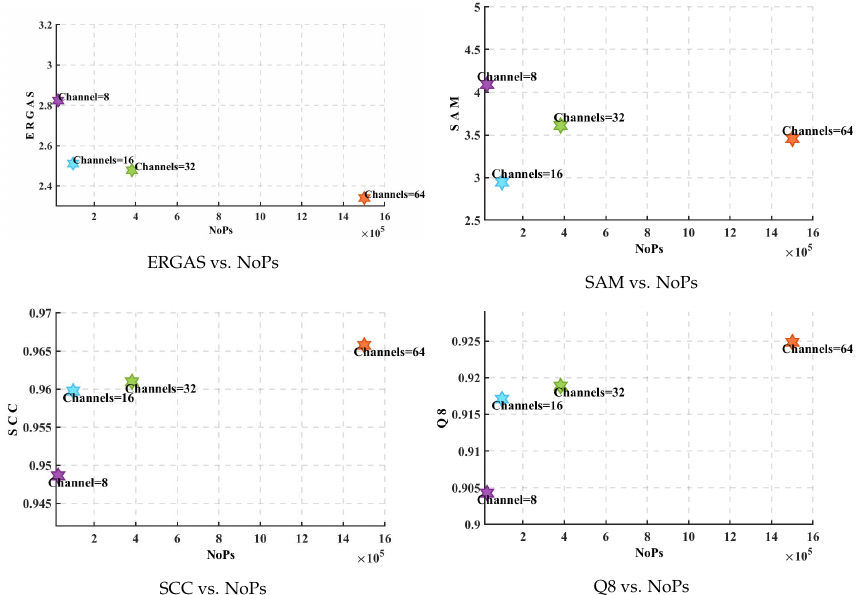
Figure 17. Number of parameters (NoPs) report and quantitative comparison of the number of channels on the Rio dataset.